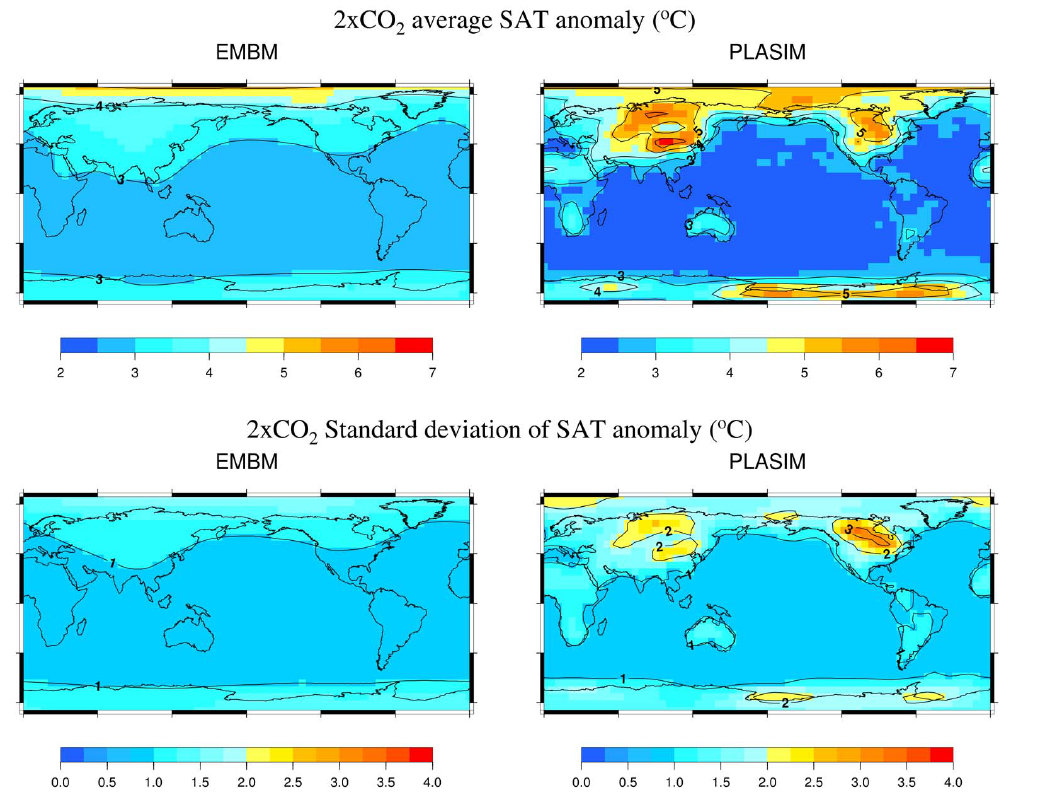
Figure 9. Mean (upper panel) and standard deviation (lower panel) of the SAT anomaly corresponding to a double in atmospheric CO 2 concentration in EMBM and